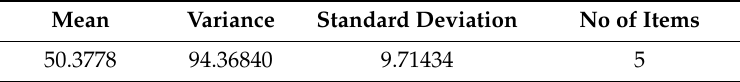
Table 5. The scale statistics (own study).